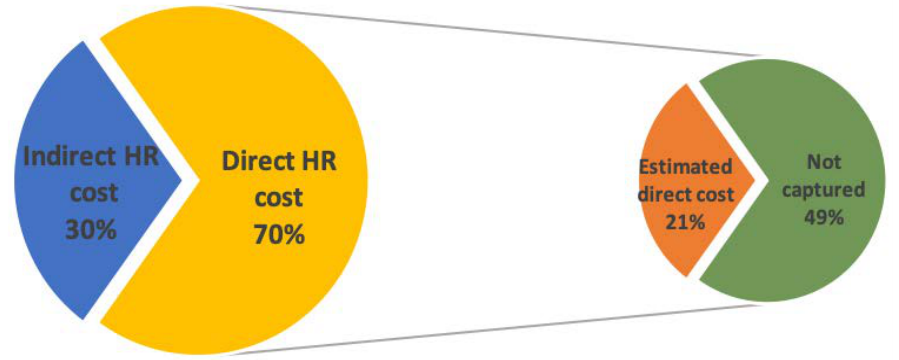
Figure 1. The human resource cost, reported by the annual report and direct human resource cost captured by